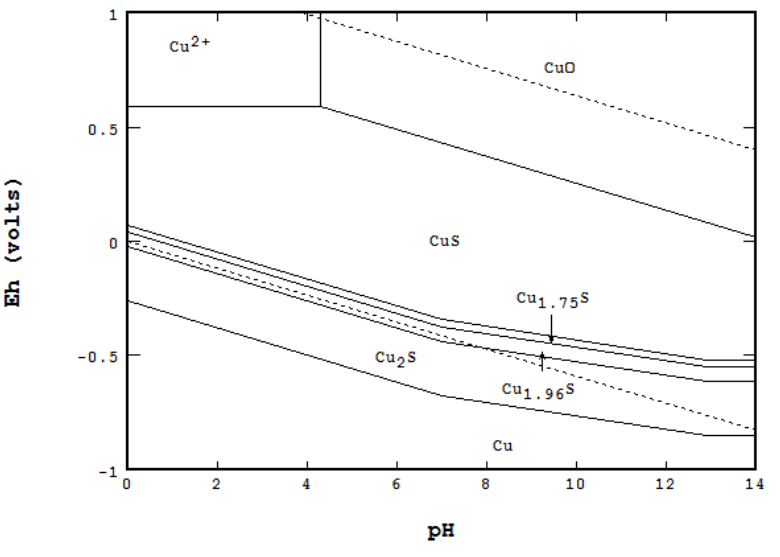
Figure 13. Eh-pH diagram for the Cu–S–water system constructed by the equilibrium line method.